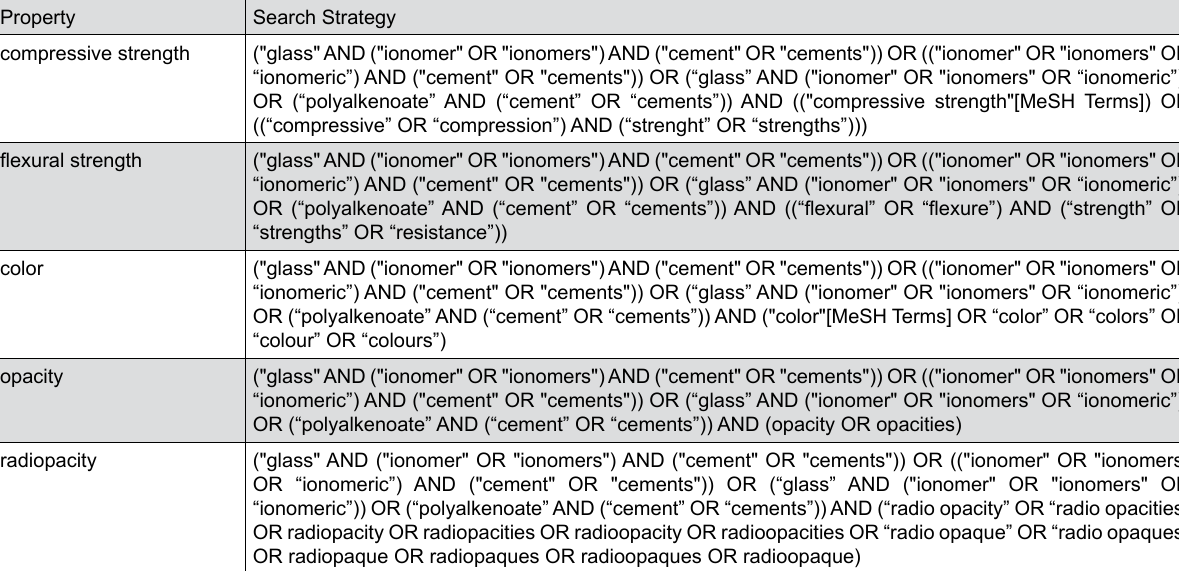
Figure 2- Search strategy used for PubMed/Medline (US National Library of Medicine - National Institutes of